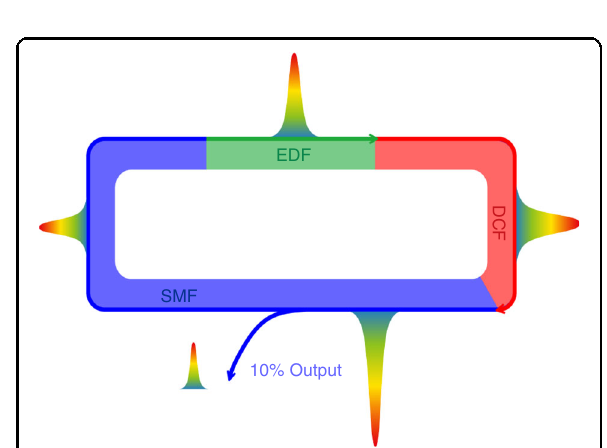
λ 2, u : central wavelength of the DSs formed along the horizontal